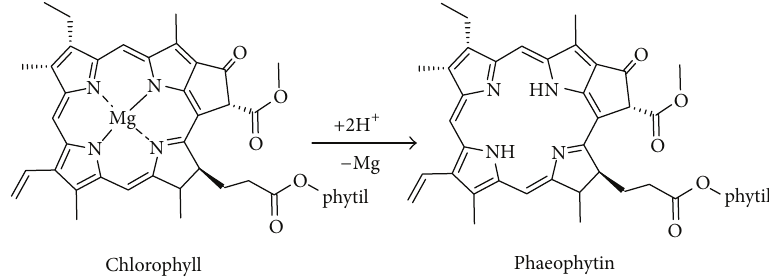
Figure 8: Reaction that occurs in the chlorophyll demetallation for the formation of